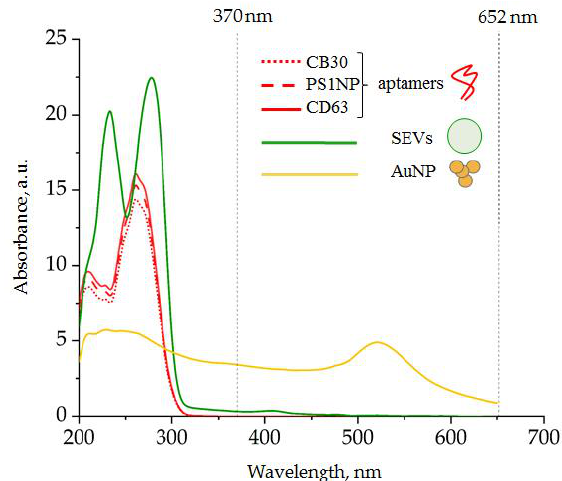
Figure 4. Spectra of individual components of the analytic system: (red) DNA aptamer, 25 mM; (green) SEVs, 6 × 10 10 particles/mL; (yellow) AuNPs, 260 mg ± 4 mg/mL.